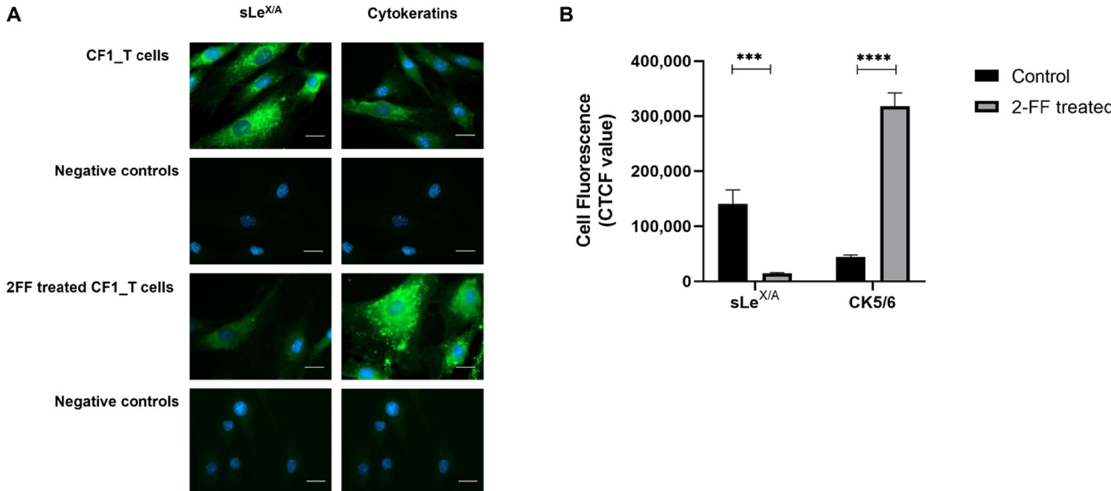
Figure 3. Inhibition of fucosylation decreases sLe X/A expression and increases cytokeratin. CF1_T cells were treated or not with 2-fluorofucose (2-FF) and then labelled with HECA-452 mAb and anti-CK monoclonal antibody (mAb), as described in the materials and methods. ( A ) Fluorescence microscopy images (scale bar: 1 μ m). The resulting fluorescence of labelling with HECA-452 and anti-CK is shown per column. The first row presents images of untreated cells stained with primary antibodies; on the second row there are the labelling controls in the absence of primary antibodies; the third row shows CF1_T cells treated with 2-FF and stained with primary antibody, and the fourth row exhibits labelling controls of 2-FF treated cells in the absence of primary antibodies. Images are representative of merging fluorescence where antibody labelling is shown in green, and nuclei were stained with 4 ′ ,6-diamidino-2-phenylindole (blue). ( B ) Corrected total cell fluorescence. The graph shows the calculated arbitrary values of corrected total cell fluorescence (CTCF) retrieved from images depicted in A as described in the materials and methods section. Legend: *** - p < 0.001, **** - p <